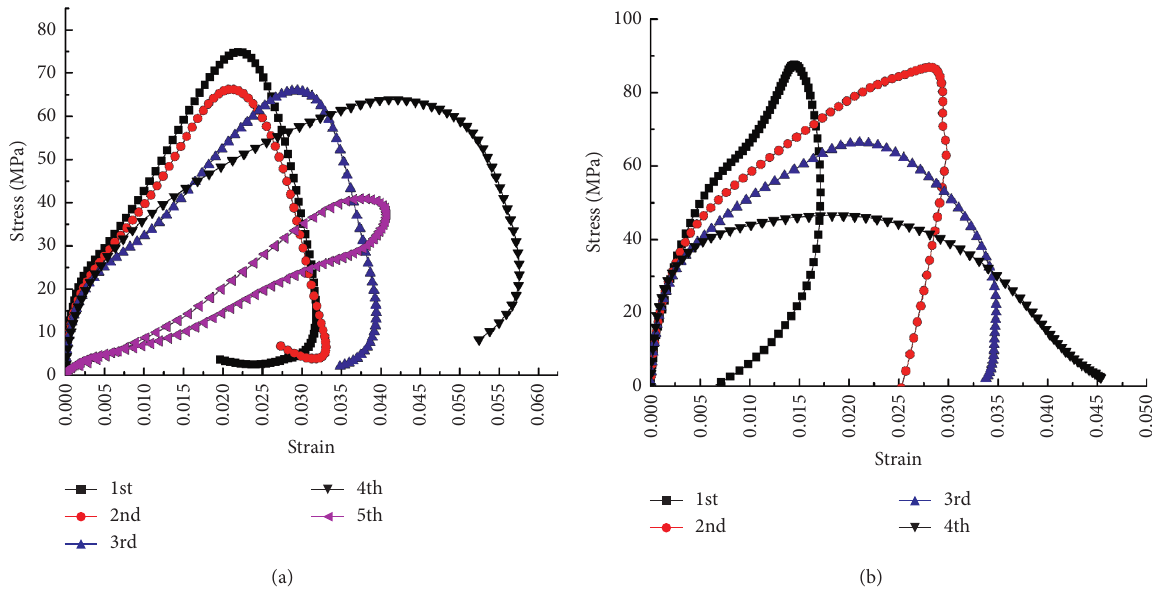
Figure 5: Cyclic impact stress-strain curves of concrete under different air pressures. (a) HC-1 (air pressure of 0.26MPa); (b) HC-2 (air pressure of 0.28